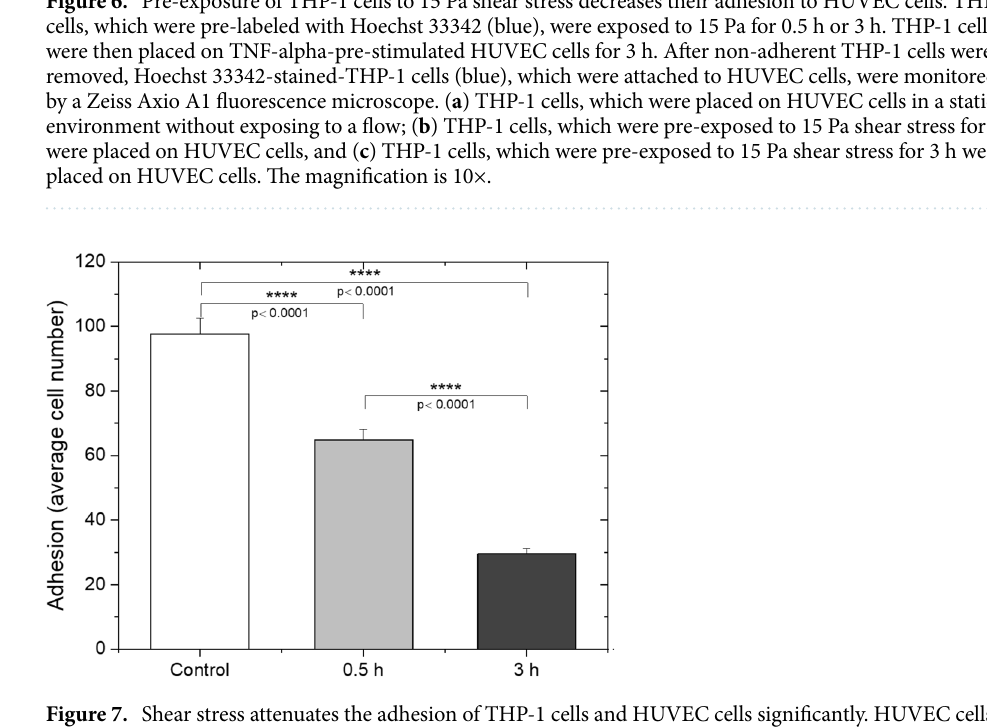
Figure 7. Shear stress attenuates the adhesion of THP-1 cells and HUVEC cells significantly. HUVEC cells were kept under static conditions, and THP-1 cells were subjected to shear stress at 15 Pa for 0.5 h and 3 h, separately, and later placed on HUVEC cells. THP-1 cells were stained with Hoescht 33342 cell tracker dye. 5 random fields were assessed to semi-quantify the adhesion level. Bar graph represents the mean value of adhesion based on two independent experiments. p values determined by ANOVA (±